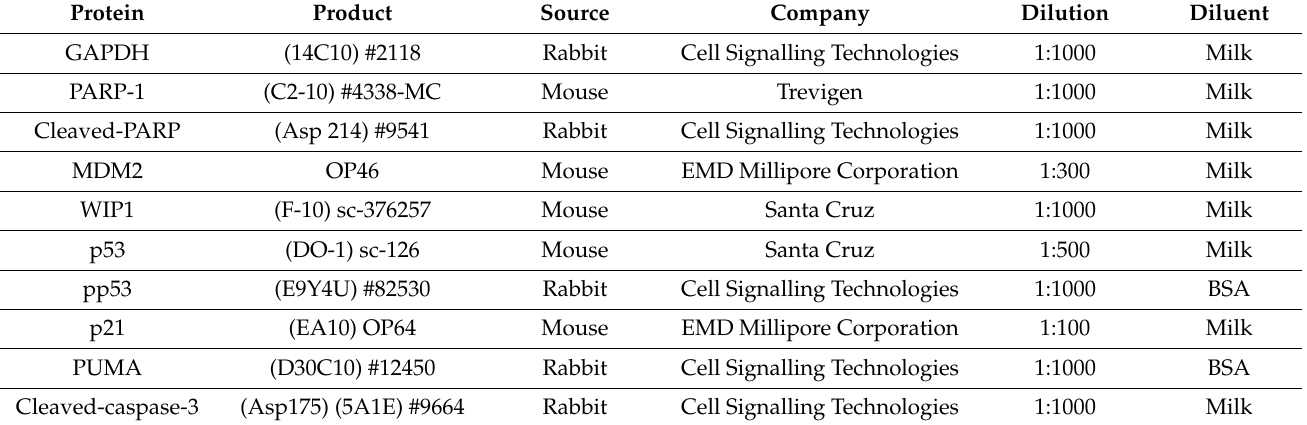
Table A1. Details of antibodies used for Western immunoblotting. BSA, Bovine serum albumin.